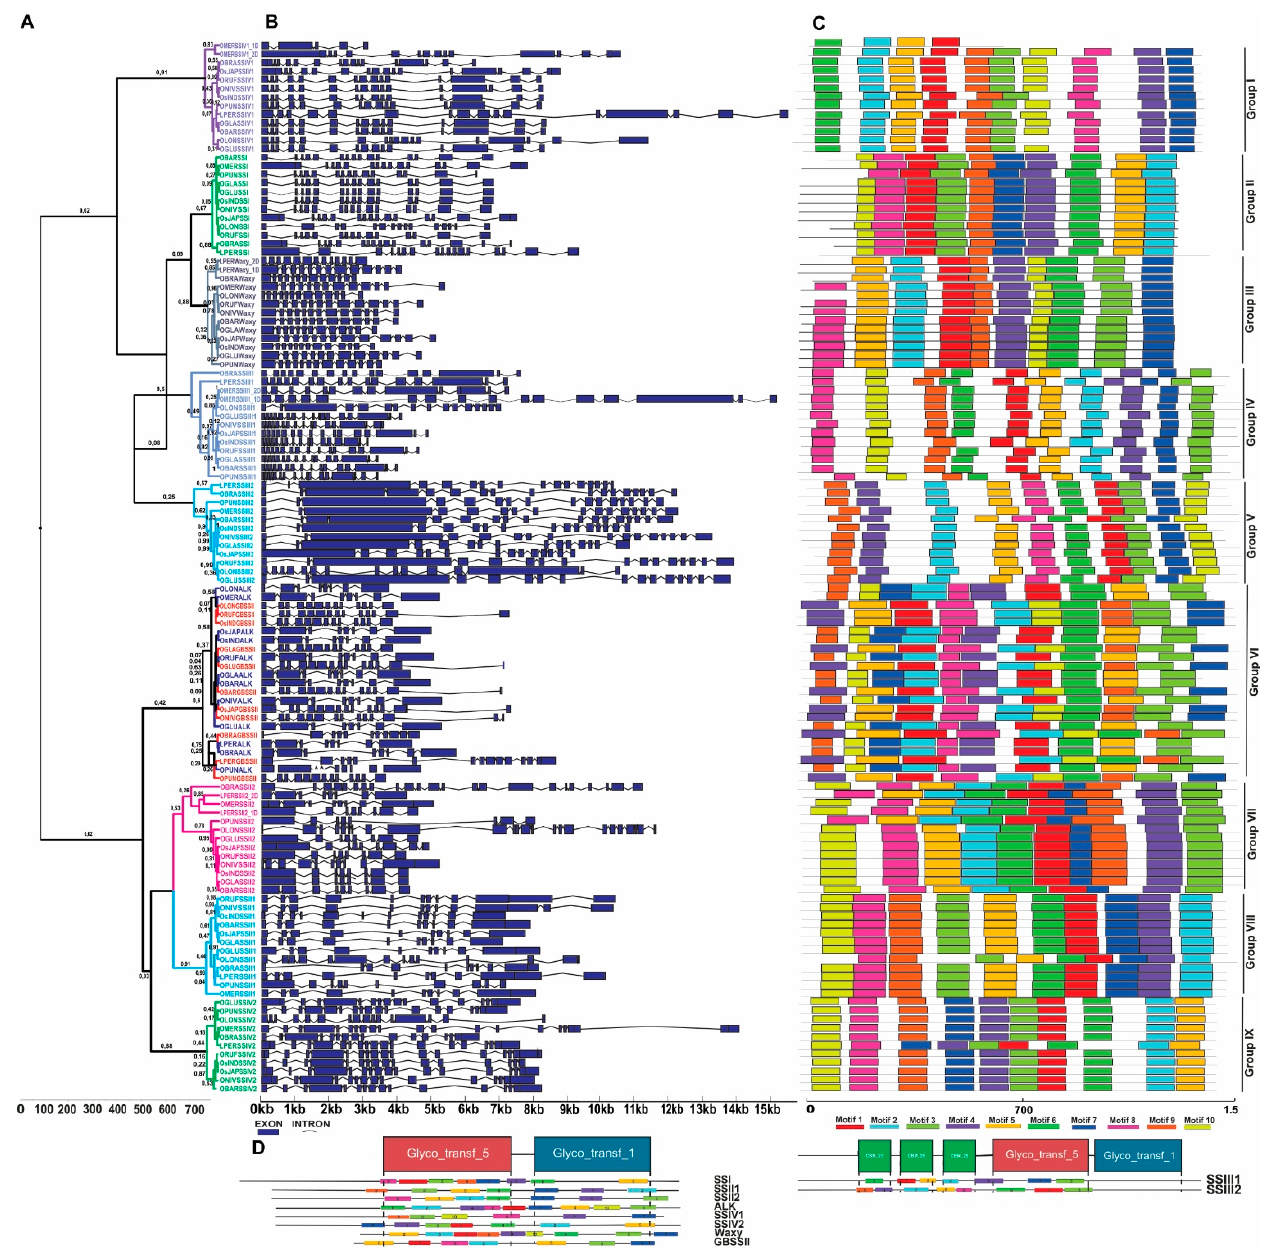
Figure 3. Phylogenetic relationship, genetic structure and conserved motifs/domain analysis in SS genes of Oryza species. ( A ) Phylogenetic protein tree and bootstrap values of SSI, SSII1, SSII2, ALK, SSIII1, SSIII2, GBSSII, Waxy, SSIV1 and SSIV2. ( B ) Exon ‐ intron structure of SS genes in Oryza . ( C ) Arrangement of the 10 most frequent motifs found in the analyzed proteins. ( D ) Composition and distribution of domains and conserved motifs of SS proteins.